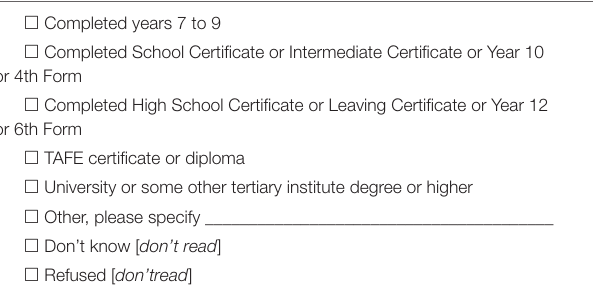
TABLE 2 | Study 1: participant